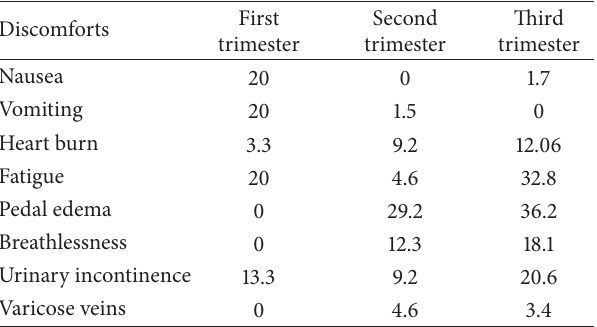
Table 2: Prevalence of general discomforts across trimesters in percentage